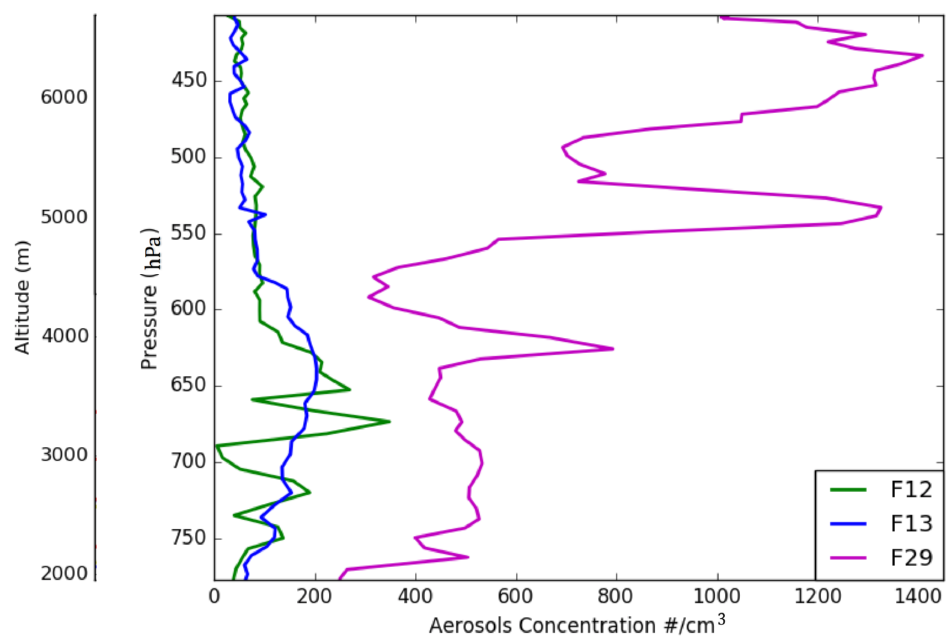
Figure 2. Aerosol concentrations measured by the PCASP in situ sensor onboard the Convair-580 just before entering the clouds for flights F12, F13, F29. Note that PCASP measurements were not available during F21